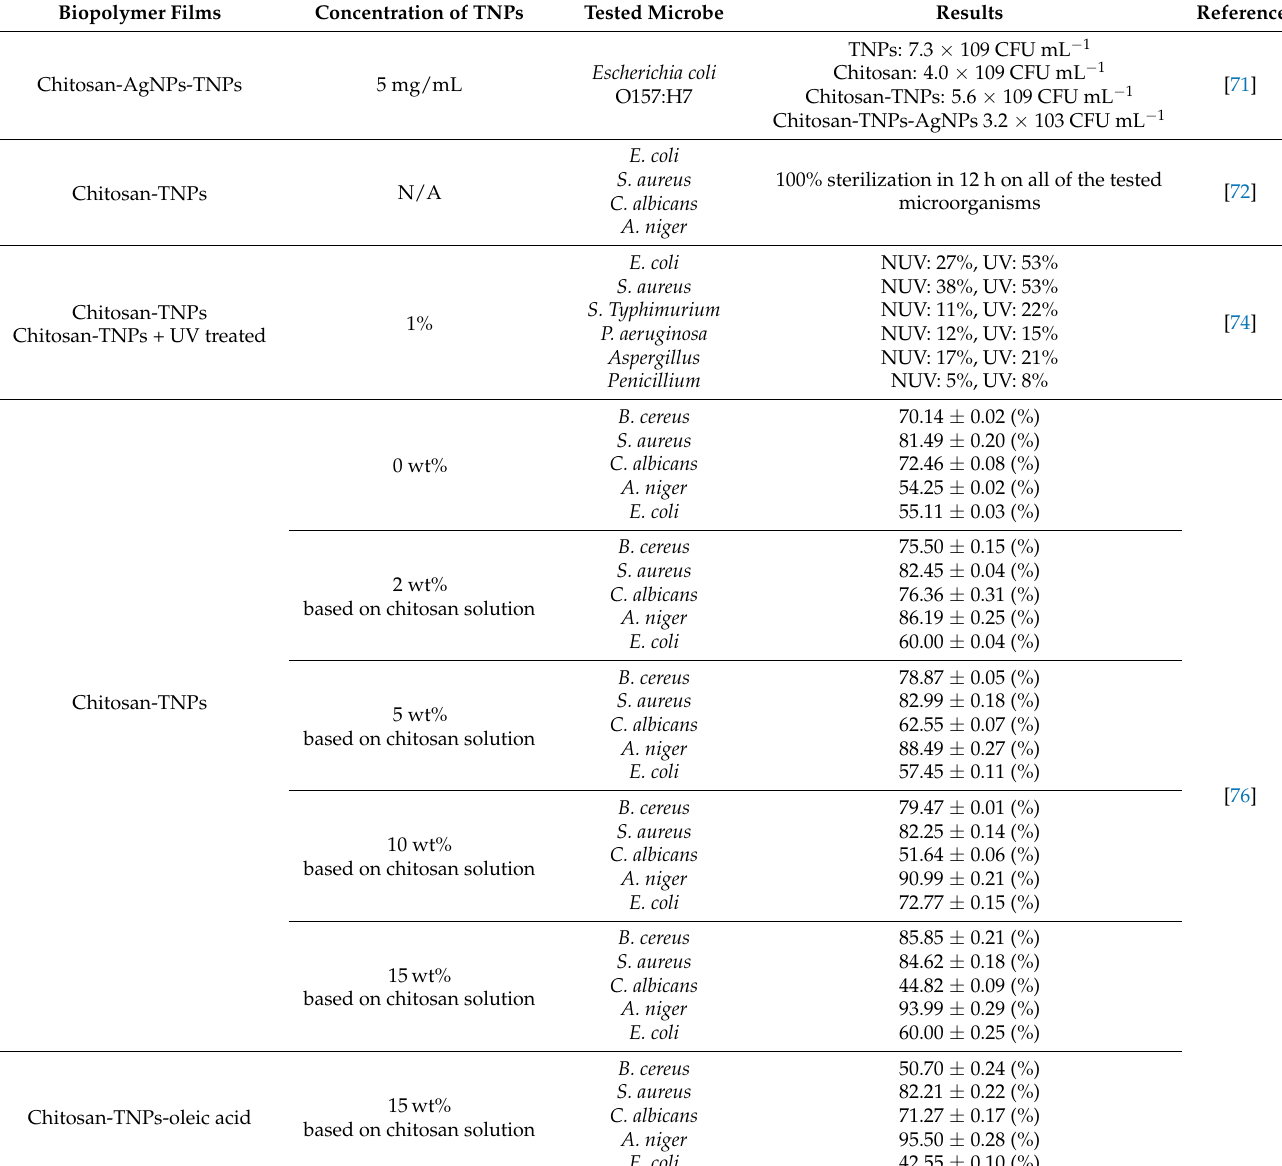
Table 1. Chitosan-TNP films antimicrobial